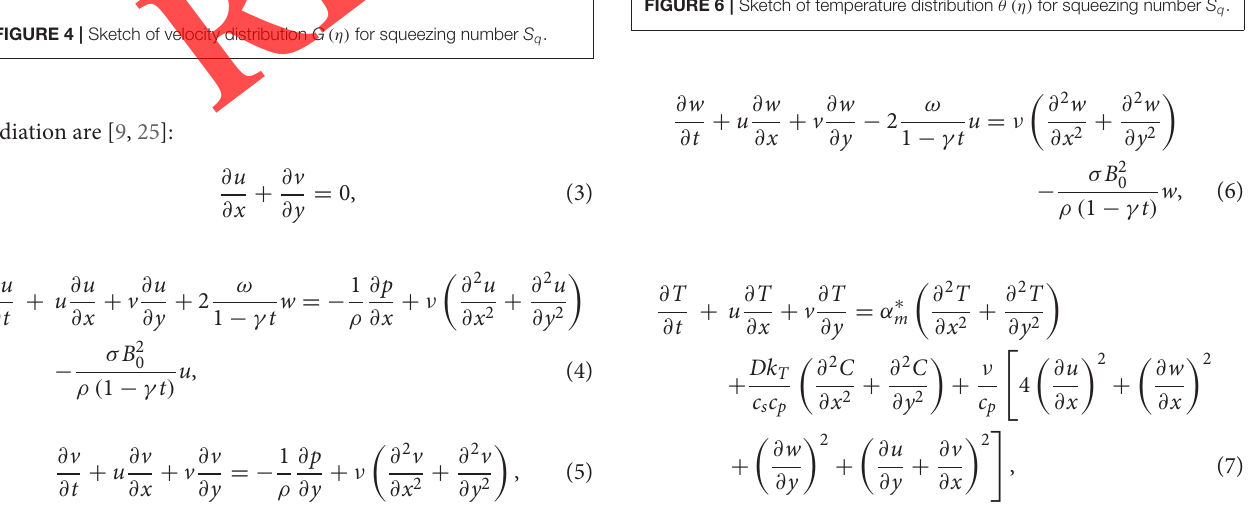
FIGURE 6 | Sketch of temperature distribution θ (η) for squeezing number S q